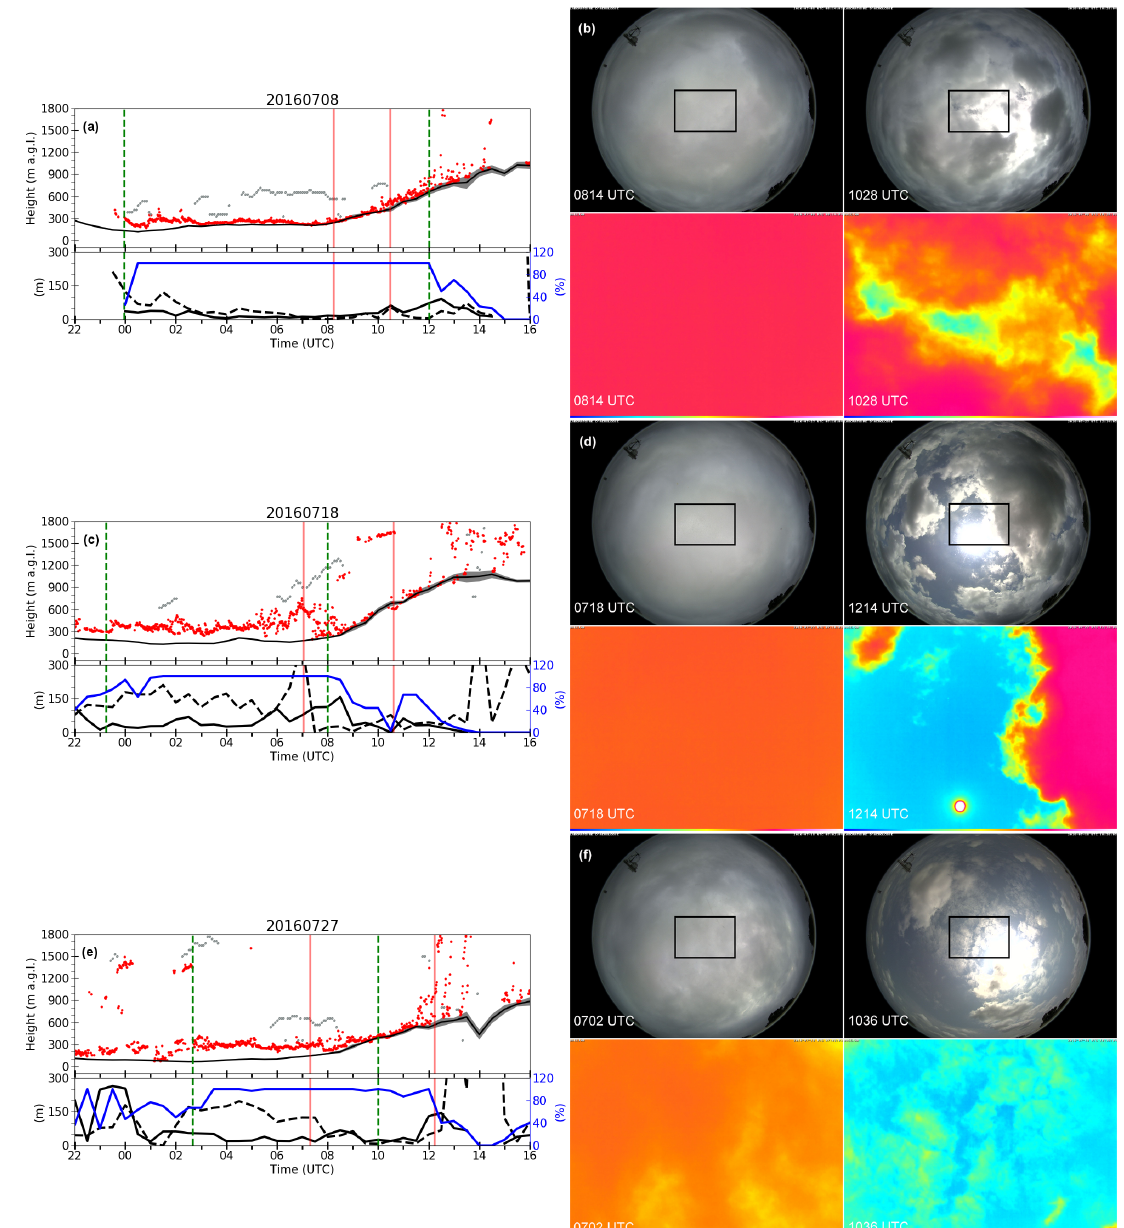
Figure 7. (a) 8 July (IOP 8), (c) 27 July (IOP 14), and (e) 18 July (IOP 11) illustrate breakup scenarios 1, 2, and 3, respectively. The temporal evolution of the cloud base height (red dots), cloud top (grey dots), and LCL with its uncertainty (black line with grey shading) are presented in the top panels. The LCL uncertainty is based on the uncertainties of the temperature and humidity used for the LCL estimation. The temporal evolution of the cloud fraction (blue line), the standard deviation of the cloud base over 30min (black line), and the difference between LCL and CBH (dashed black line) are presented in the bottom panels. The vertical dashed green lines indicate the LLSC onset and breakup times. The vertical red lines indicate the times of the visible and infrared camera pictures presented in (b) , (d) , and (f) for IOP 8, IOP 14 , and IOP 11, respectively. The times are 08:14 and 10:28UTC on 8 July, 07:18 and 12:14UTC on 27 July, and 07:02 and 10:36UTC on 18 July. The colour scale for the infrared images (indicated at the bottom of the images) ranges from blue, for colder brightness temperatures, to white for the warmer brightness temperatures. The black rectangle on the visible images indicates the area corresponding to the infrared images. The white dot in the infrared images, at 12:14UTC on 27 July and 10:36UTC on 18 July, is due to the sun and is located at the centre of the solar